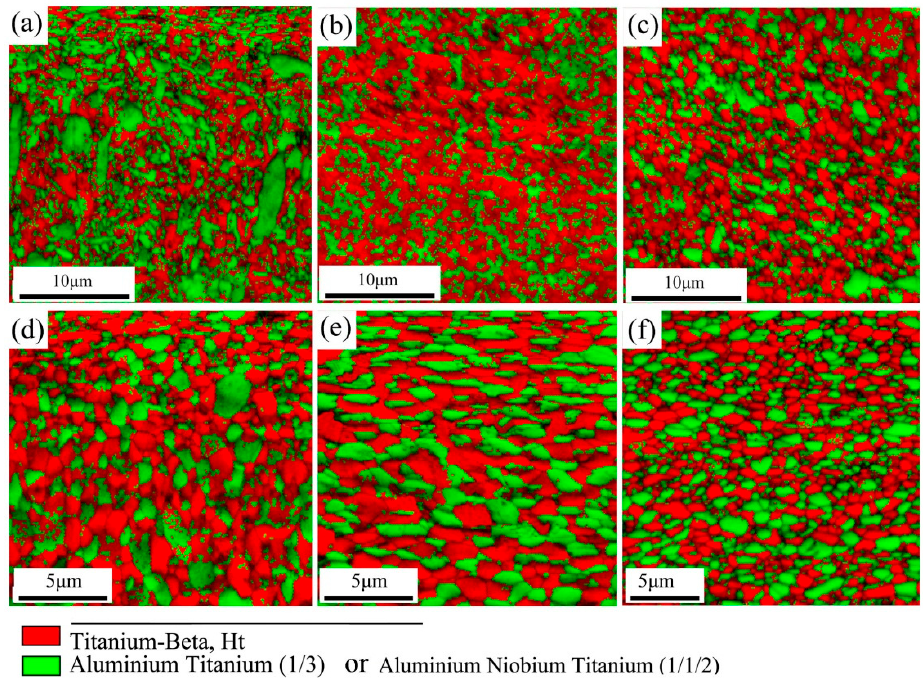
Figure 5. Phase and image quality (IQ) maps of the as-rolled and can-compressed samples subject to annealing treatment: ( a ) as-rolled, ( b ) 25%, ( c ) 50%, ( d ) 60%, ( e ) 65%, and ( f ) 75%.